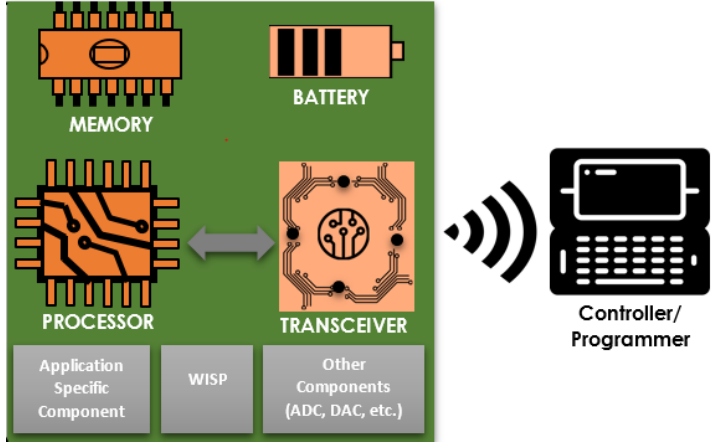
Figure 1. A typical IMD system architecture.